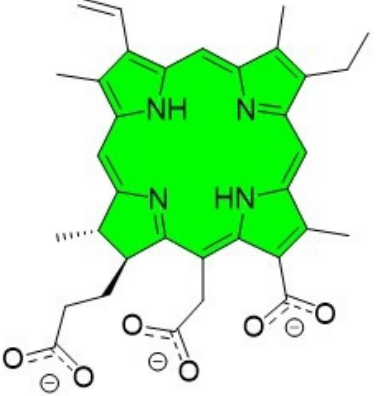
Figure 2. The chemical structure of chlorin e6 (Ce6).